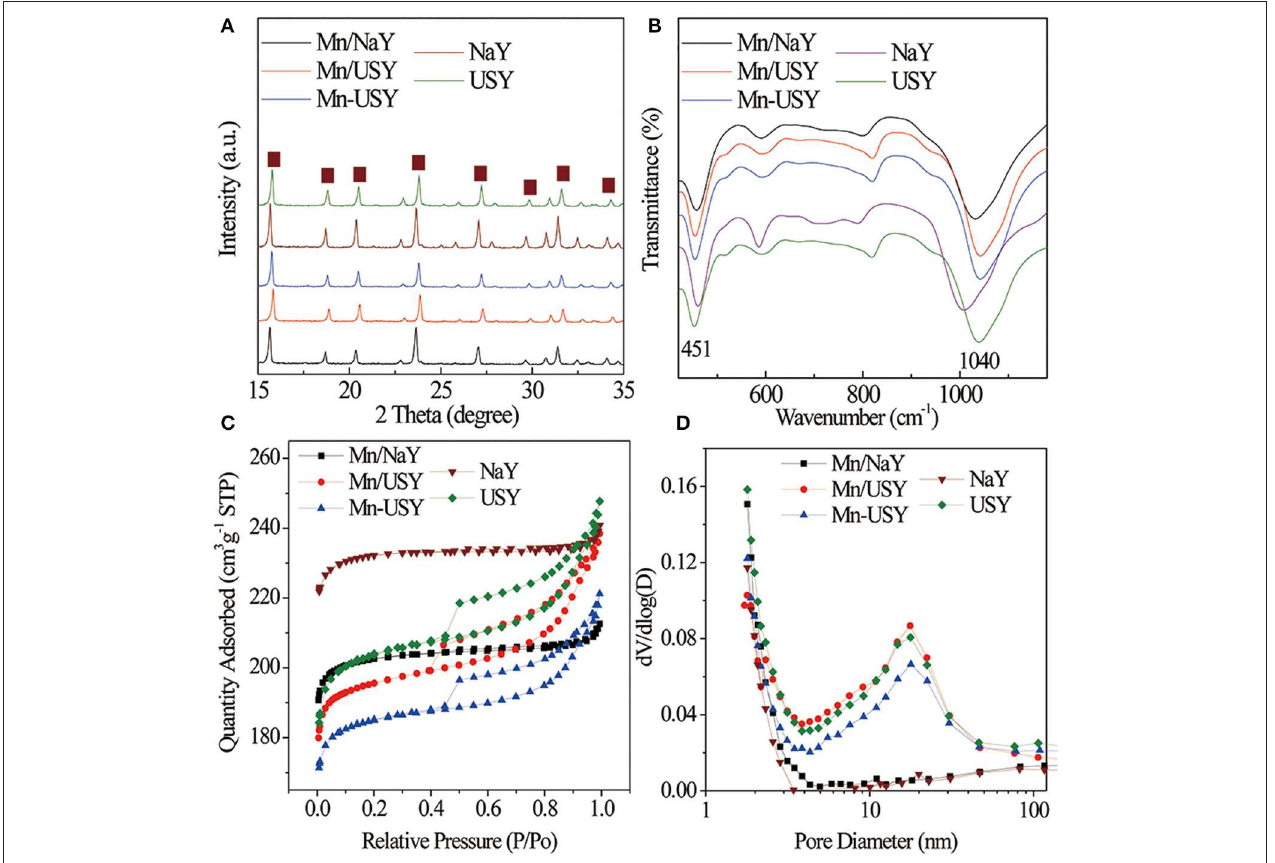
FIGURE 1 | XRD spectra (A) , FT-IR (B) spectra, adsorption-desorption isotherms (C) , and pore distributions (D) of Mn-based Y zeolites.